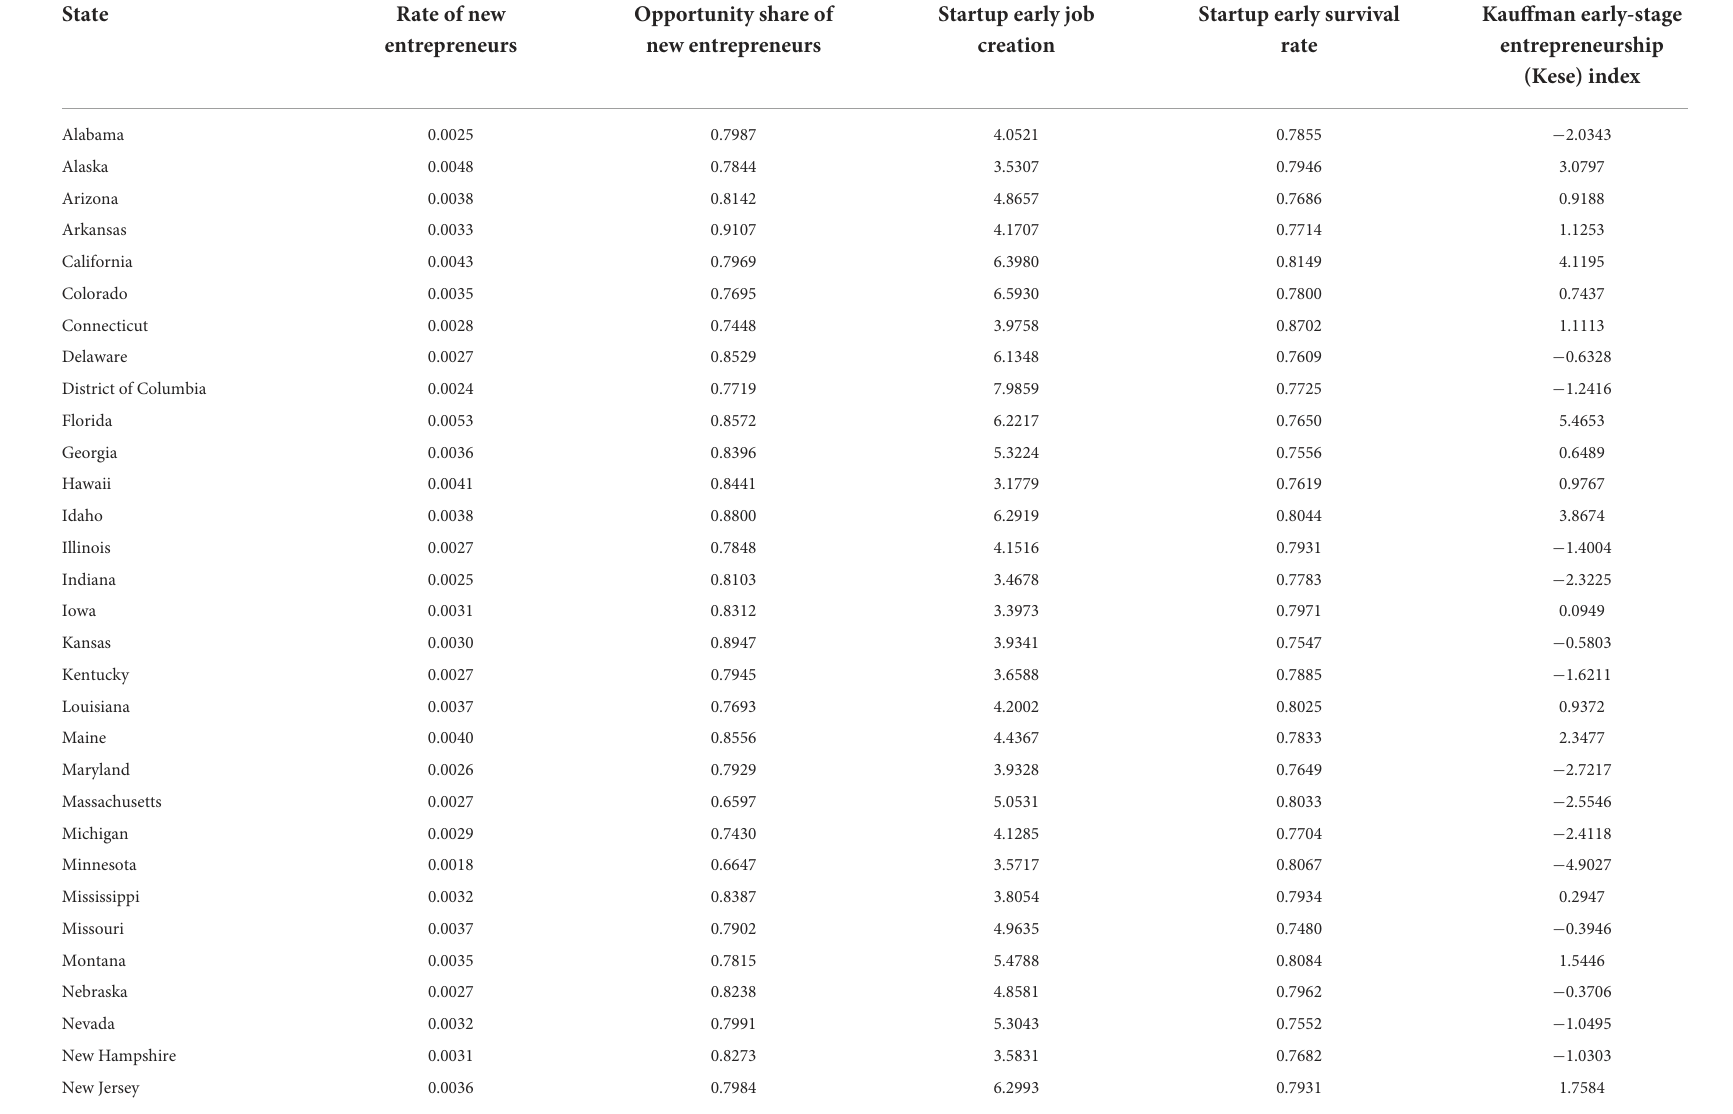
TABLE 3 State level early-stage entrepreneurship indicators in the United States in